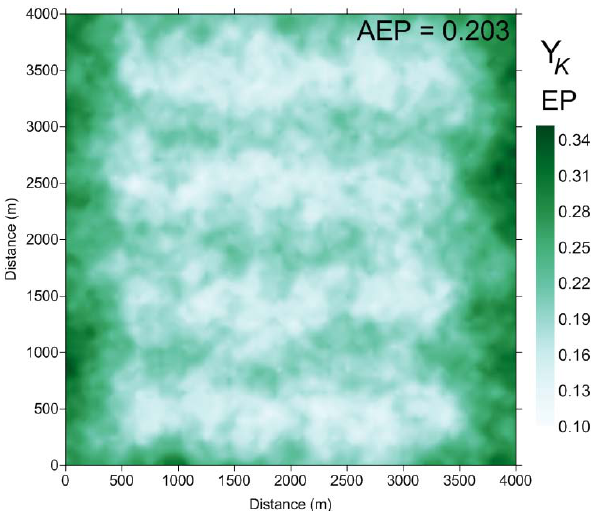
Figure 10. Spatial distribution of the mean of the updated 6 along the stream channel sampled four times during the 365 7 along the stream channel sampled four times during the 365-day period, with the CV of observation data set to 0.0. Compare to the true state shown in Figure 5A. 8 0.0. Compare to the true state shown in Figure 5A. 9 10 11 12